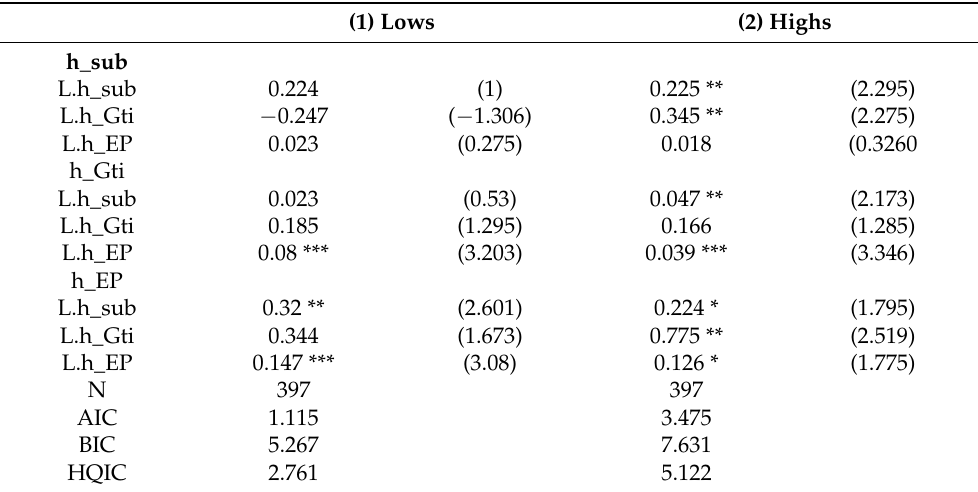
Table 6. Summary of GMM estimation results of PVAR model based on heterogeneity of enterprise asset growth.